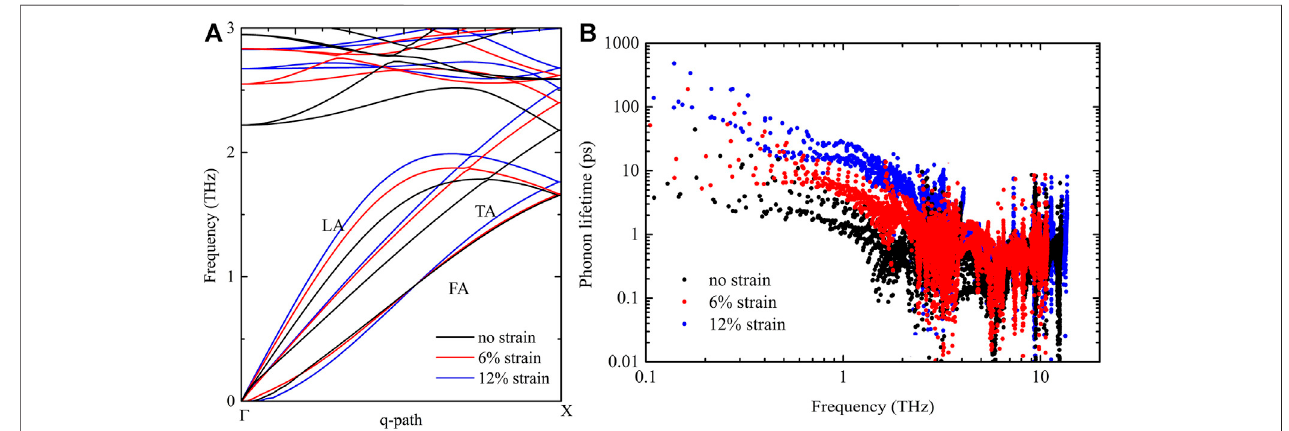
FIGURE 4 | (A) Phonon dispersion curves of acoustic phonon branches of bilayer penta-Si along the Γ − X direction at typical tensile strains. (B) Frequency- dependent phonon lifetime of bilayer penta-Si at typical tensile strains.